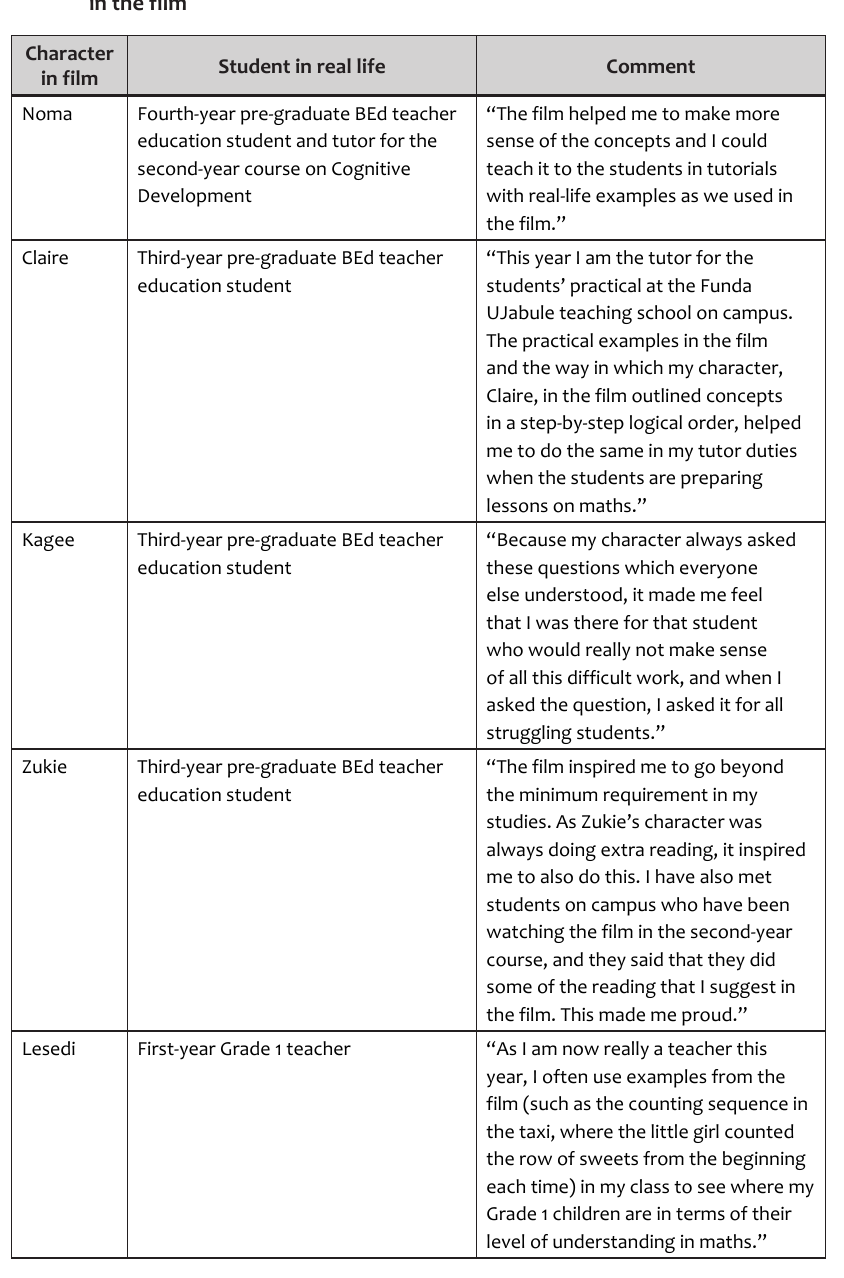
Table 2: Comments from actors showing how they benefitted from their participation in the